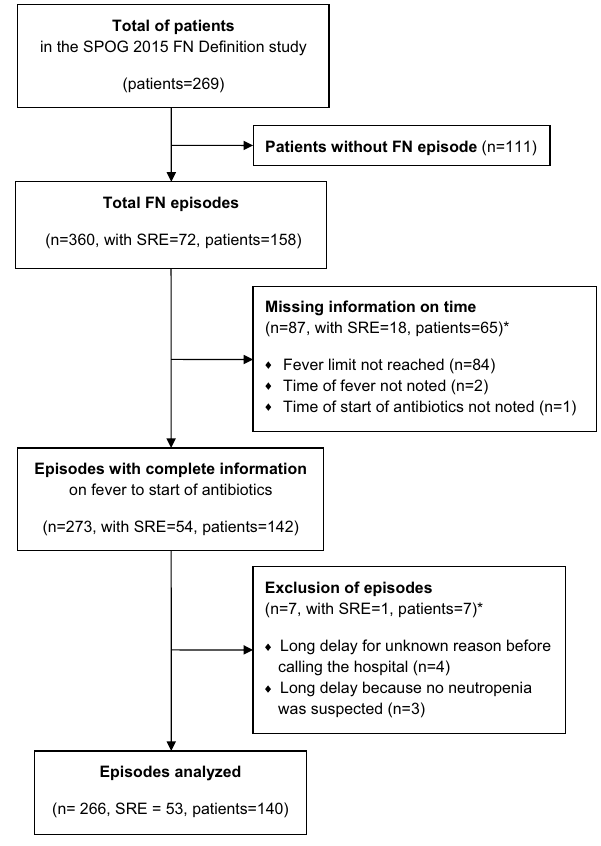
Figure 2. Flow chart of patients and episodes analyzed for fever (38.5 °C or 39.0 °C) to start of antibiotics